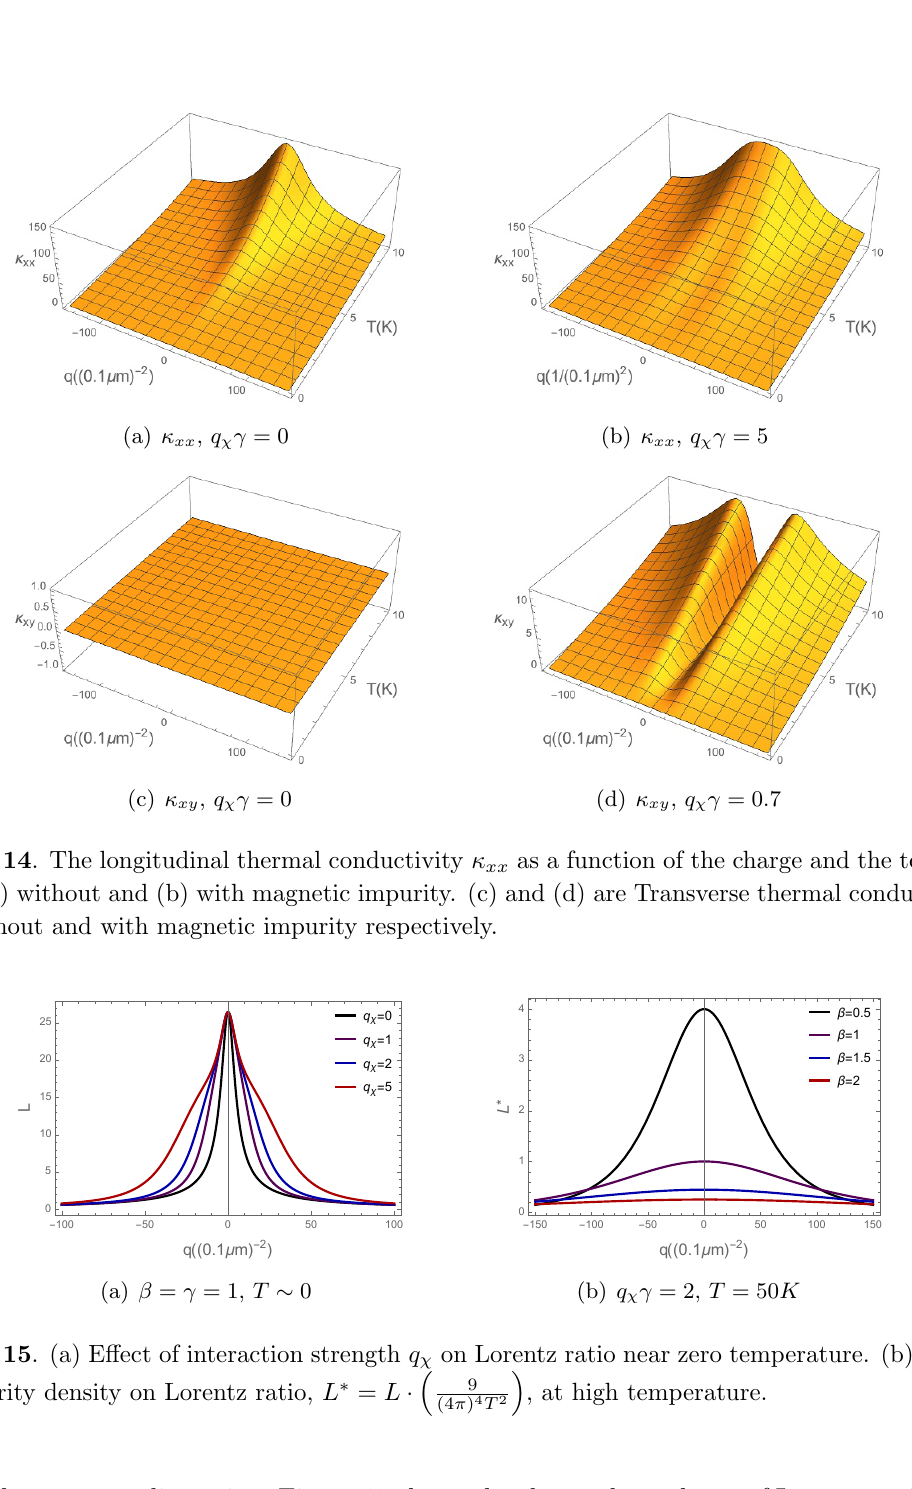
(cid:16) (cid:17) 9 , at high (4 (cid:25) ) 4 T 2